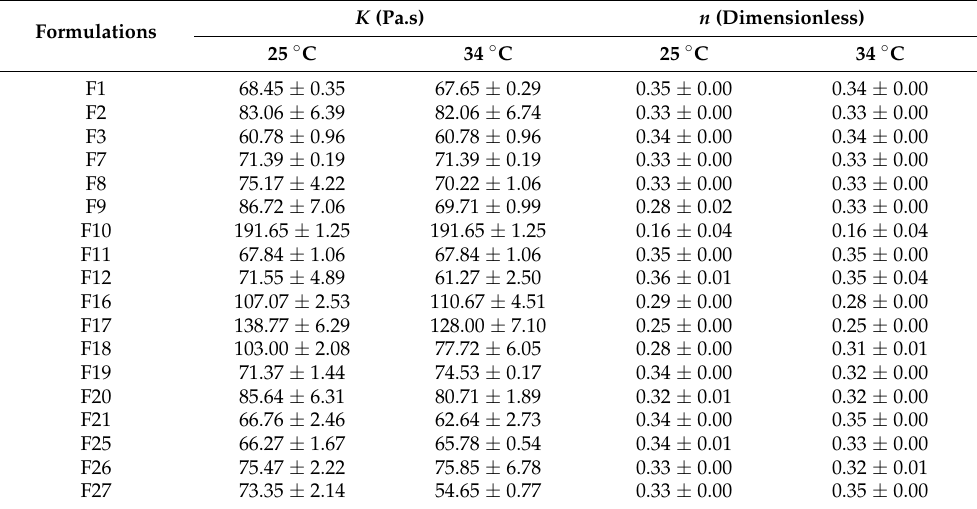
Table 1. The effects of different types of polymer (C934P, C974P, PC), oil (PF, AN) and bioactive agent combinations (PE, CUR, PE+CUR) on the consistency index ( K ) and rheological exponent ( n ) of emulgels at 25 and 34 ◦